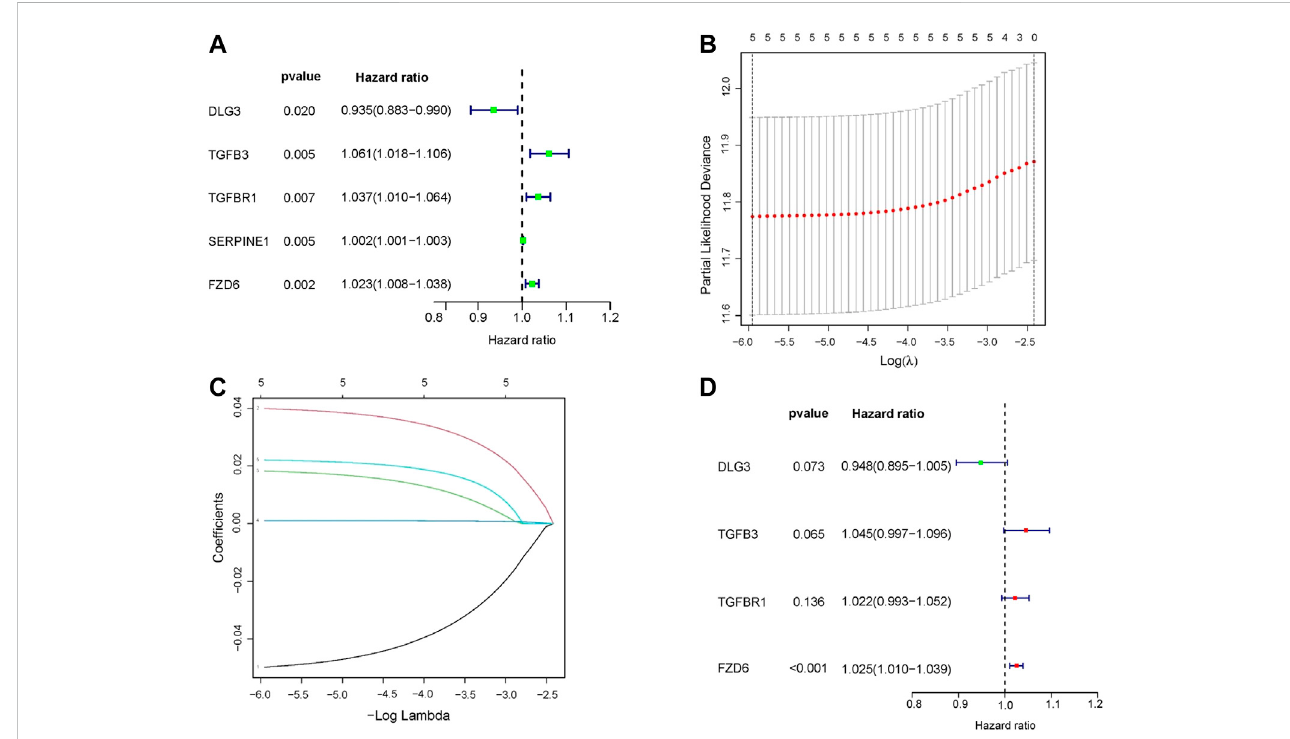
FIGURE 2 Construction of a HSPRGs signature for the prognosis of GC. (A) Univariate cox regression analysis (B) The minimum value was selected as the optimal parameter ( λ ) in the LASSO signature (C) LASSO coef fi cient map of prognosis-related HSPRGs. (D) Multivariate cox regression analysis.